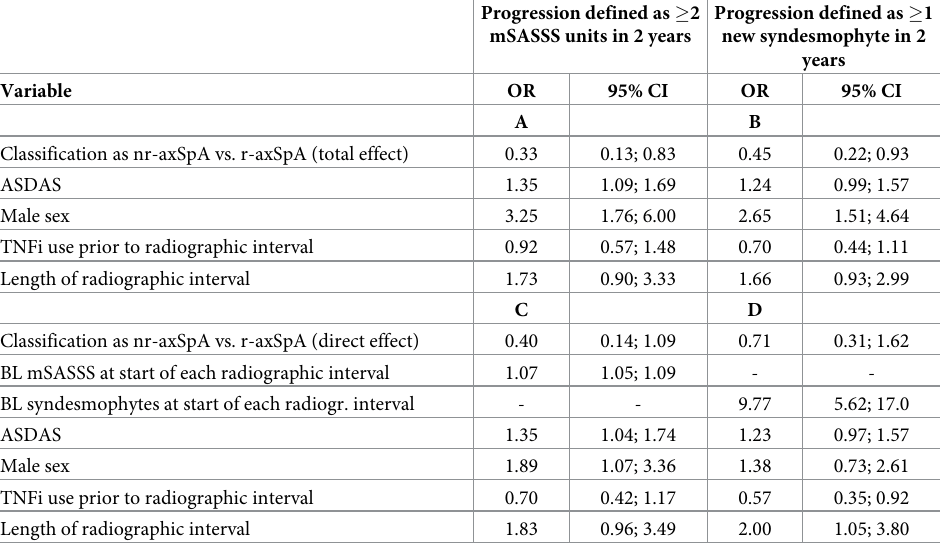
Table 3. Multivariable analysis for the identification of factors associated with spinal radiographic progression in axSpA. Progression defined as � 2 Progression defined as � 1 mSASSS units in 2 years new syndesmophyte in 2 years Variable OR 95% CI OR 95% CI A B Classification as nr-axSpA vs. r-axSpA (total effect) 0.33 0.13; 0.83 0.45 0.22; 0.93 ASDAS 1.35 1.09; 1.69 1.24 0.99; 1.57 Male sex 3.25 1.76; 6.00 2.65 1.51; 4.64 TNFi use prior to radiographic interval 0.92 0.57; 1.48 0.70 0.44; 1.11 Length of radiographic interval 1.73 0.90; 3.33 1.66 0.93; 2.99 C D Classification as nr-axSpA vs. r-axSpA (direct effect) 0.40 0.14; 1.09 0.71 0.31; 1.62 BL mSASSS at start of each radiographic interval 1.07 1.05; 1.09 - - BL syndesmophytes at start of each radiogr. interval - - 9.77 5.62; 17.0 ASDAS 1.35 1.04; 1.74 1.23 0.97; 1.57 Male sex 1.89 1.07; 3.36 1.38 0.73; 2.61 TNFi use prior to radiographic interval 0.70 0.42; 1.17 0.57 0.35; 0.92 Length of radiographic interval 1.83 0.96; 3.49 2.00 1.05; 3.80 Results from different multivariable models with spinal radiographic progression defined as an increase of � 2 mSASSS units per 2 years ( A, C ) and progression defined as the formation of � 1 syndesmophyte in 2 years ( B, D ). Analyses performed in 725 radiographic intervals from 506 patients, according to Fig 1, either assessing the total or the direct effect of classification criteria on spinal progression by ignoring or considering baseline spinal damage ( A, B or C,D , respectively). ASDAS = Ankylosing Spondylitis Disease Activity Score; CI = confidence interval; mSASSS = modified Stoke Ankylosing Spondylitis Spine Score; nr-axSpA = nonradiographic axial spondyloarthritis; OR = odds ratio; r-axSpA = radiographic axial spondyloarthritis; TNFi = Tumour necrosis factor inhibitor. https://doi.org/10.1371/journal.pone.0230268.t003 inflammation and ultimately to osteoproliferation in spondyloarthritis [24], these changes in function and mobility of the spine due to sacroiliac damage might theoretically increase syn- desmophyte formation. However, our mediation analyses in this longitudinal study of patients with nr-axSpA versus r-axSpA failed to demonstrate a statistically significant direct association